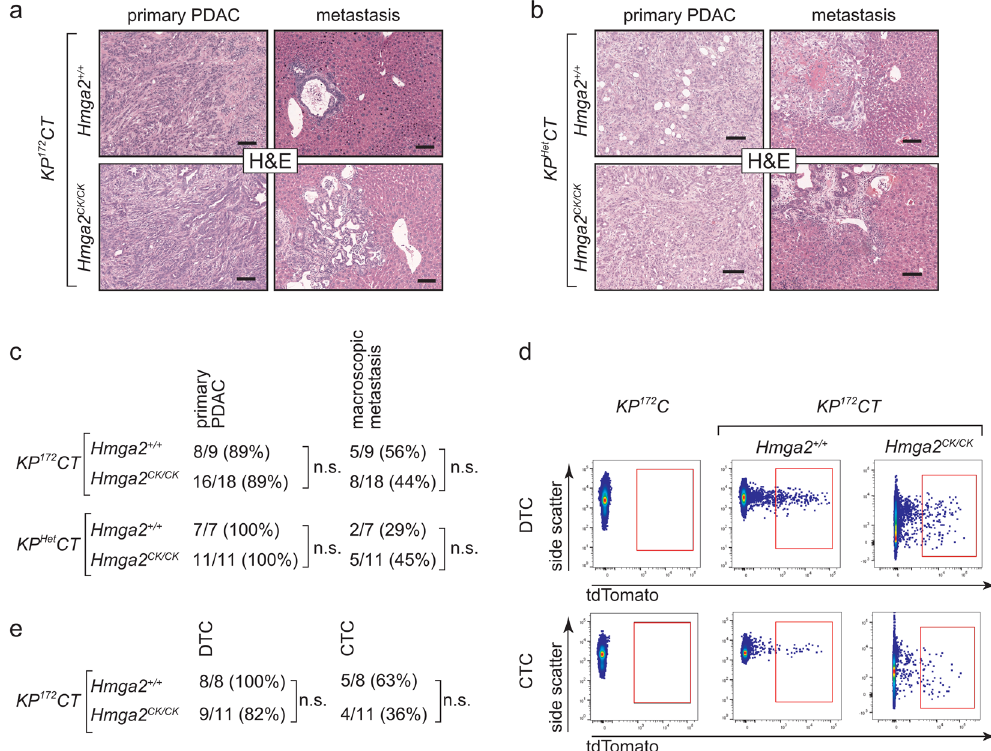
Figure 2. Hmga2 deficiency does not alter the phenotype of pancreatic cancer in multiple autochthonous mouse models. ( a,b ) Representative histology of primary PDAC tumours and metastases from KP 172 CT ( a ) and KP Het CT ( b ) mice with ( Hmga2 + / + ) or without ( Hmga2 CK/CK ) Hmga2. Scale bars = 100 µ m. ( c ) Incidence of primary PDAC and metastases in KP 172 CT and KP Het CT mice with ( Hmga2 + / + ) or without ( Hmga2 CK/CK ) Hmga2. All comparisons showed no significant differences. ( d,e ) Incidence of circulating tumour cells (CTC) and disseminated tumour cells (DTC) is comparable in KP 172 CT;Hmga2 + / + and KP 172 CT;Hmga2 CK/CK mice ( e ) as detected by FACS ( d ) for tdTomato pos , lineage neg , DAPI neg cancer cells in blood (CTC) and pleural fluid (DTC). No significant differences in CTC number were